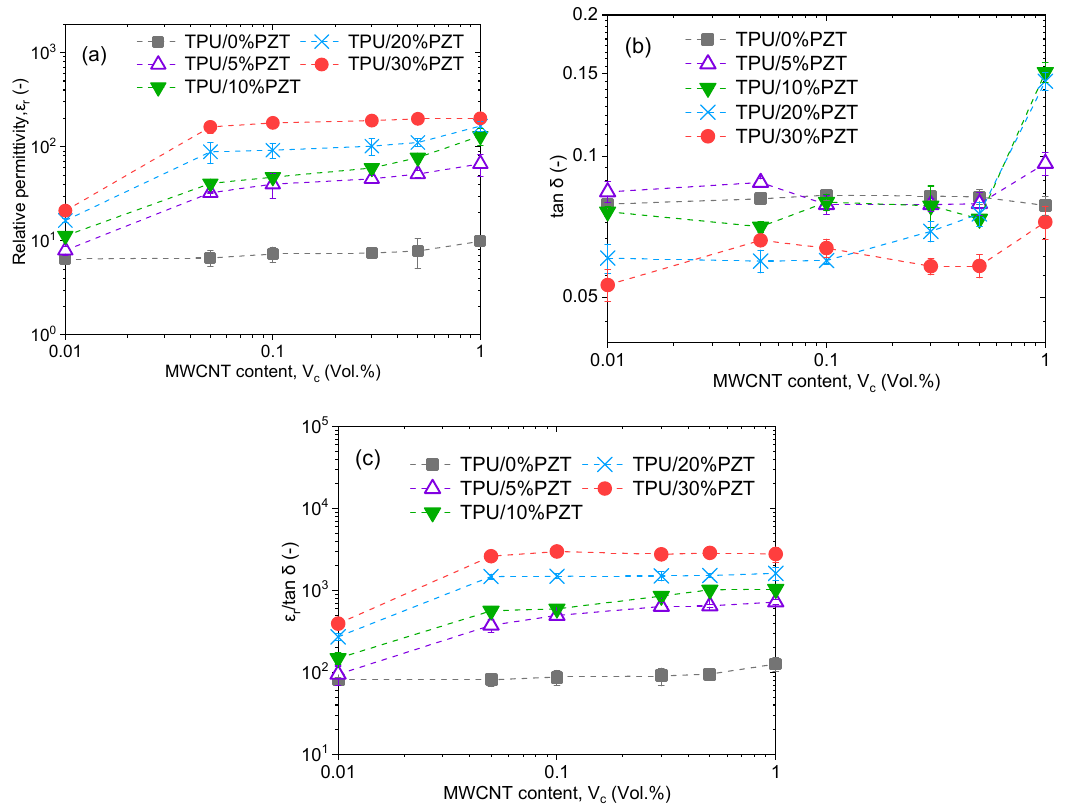
Figure 8. ( a ) Relative permittivity, ε r , ( b ) dielectric loss, tan δ , and ( c ) ε r / tan δ ratio of TPU / PZT / MWCNT composites as a function of MWCNT content at various PZT loadings at a frequency of 10 5 Hz.